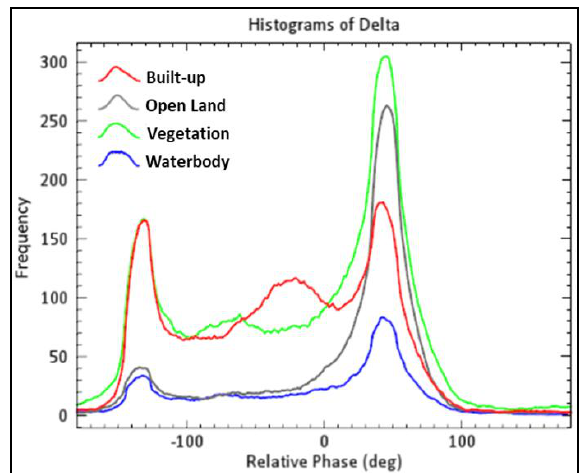
Figure 4: Histogram of Relative phase, δ in different Land cover classes